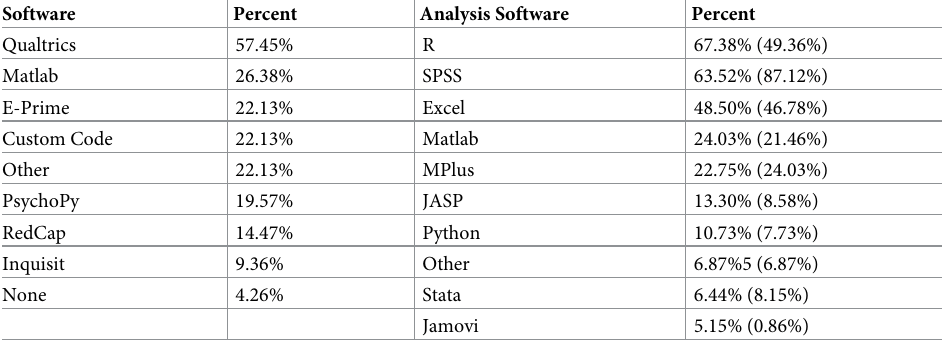
Table 3. Software tools used for data collection and analysis. Software tools used to collect and analyze data. Paren- theses for analysis software indicate the tools participants were taught to use as part of their education in research methods and statistics. “Other” responses for data collection software were largely comprised of survey tools (e.g. Sur- vey Monkey, LimeSurvey) and tools for building and running behavioral experiments (e.g. Gorilla, JsPsych).